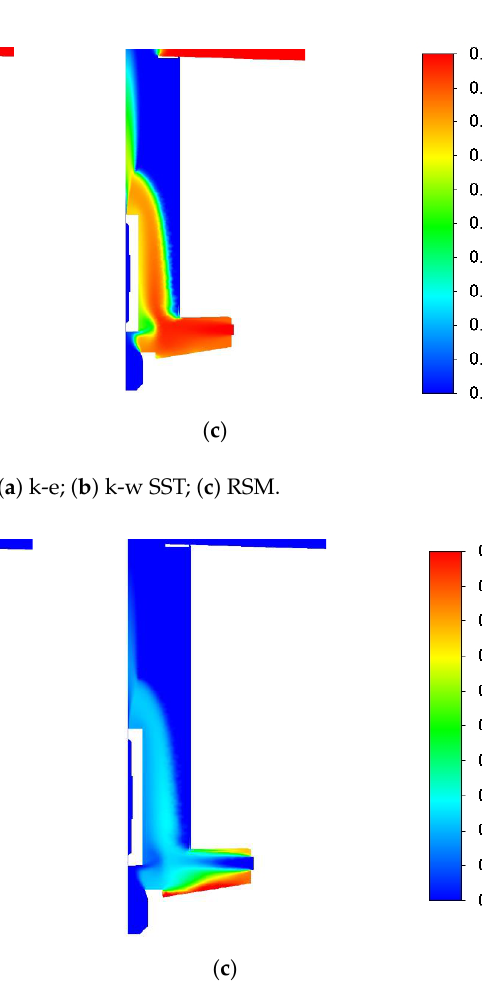
Figure 8. Volume fraction of C 7 H 16 : ( a ) k-e; ( b ) k-w SST; ( c ) RSM.